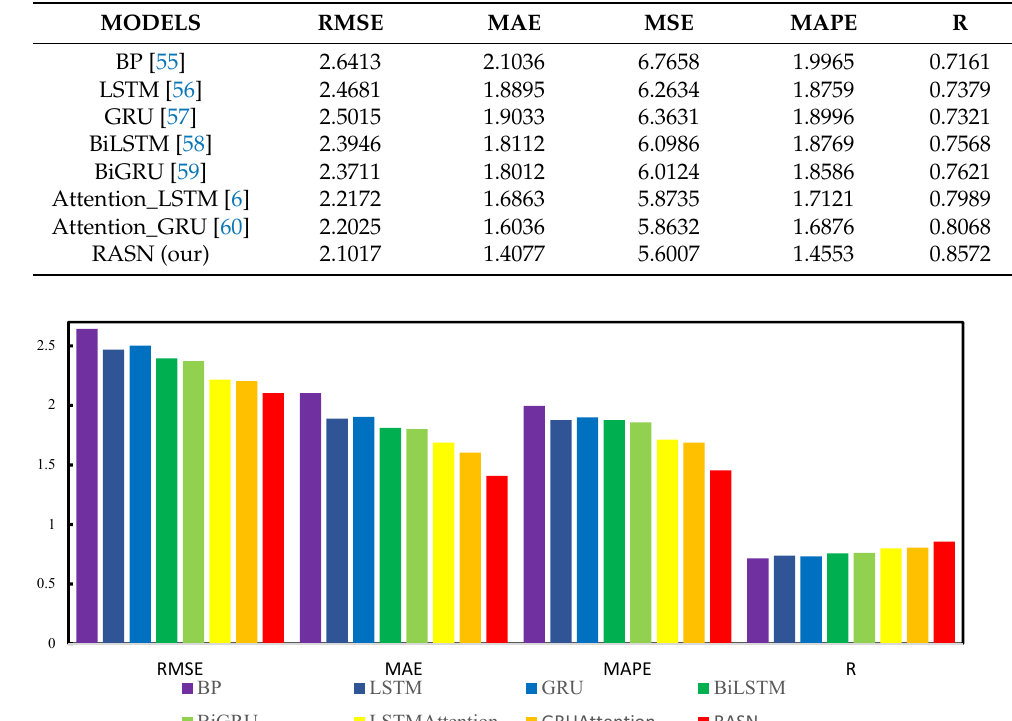
Table 6. Comparison of model prediction performance based on CO 2 data.